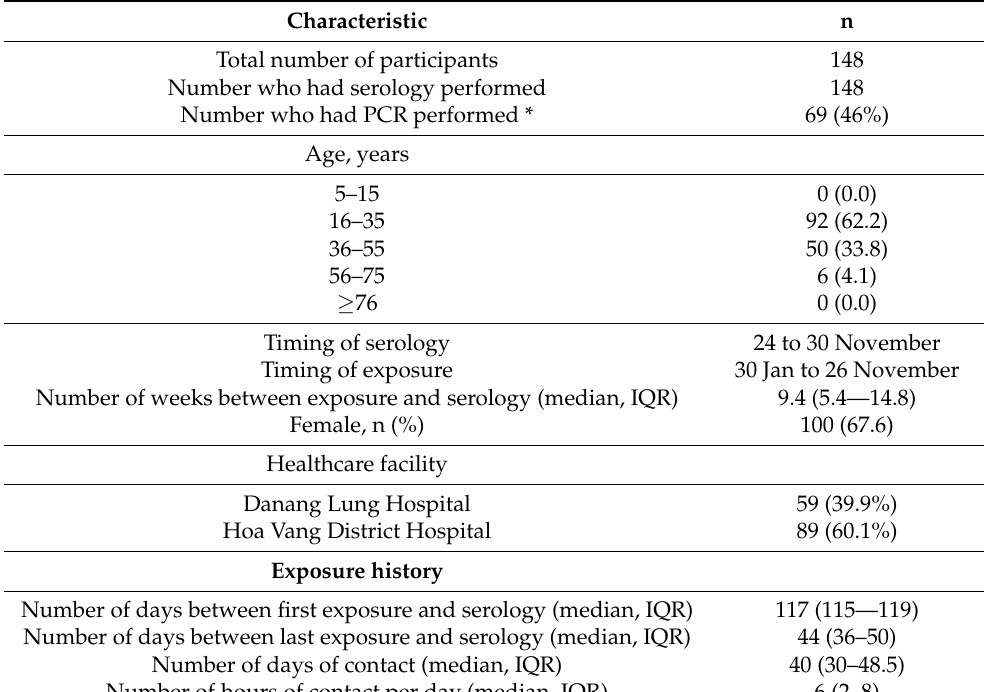
Table 3. Characteristics of health care workers participating in the